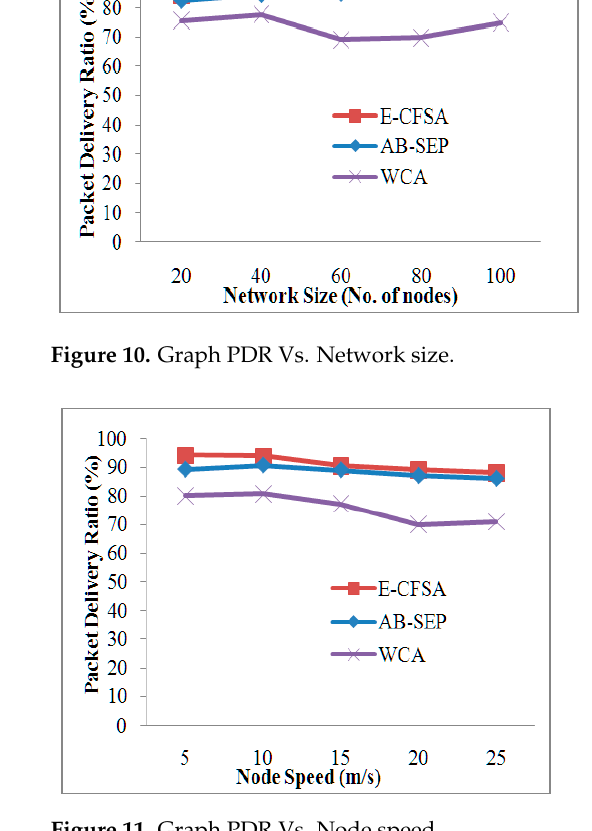
Figure 11. Graph PDR Vs. Node speed.